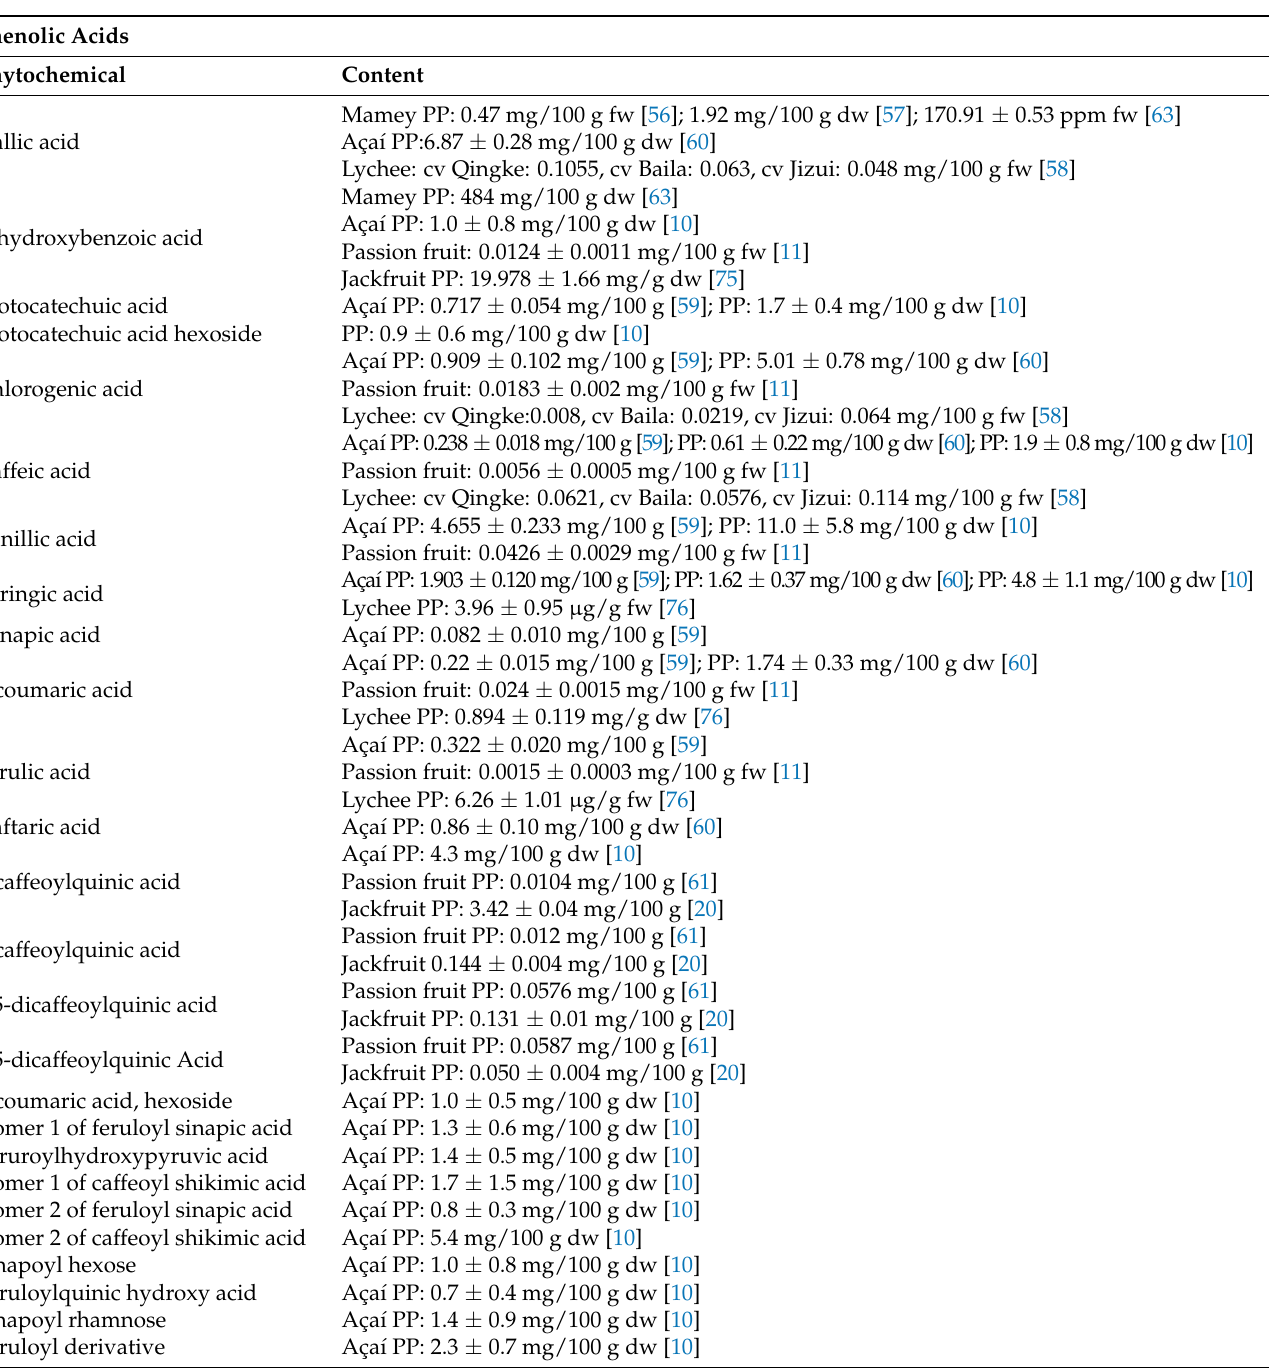
Table 2. Phytochemical content in the pulp, seed, and peel of mamey, aça í , passion fruit, lychee, and